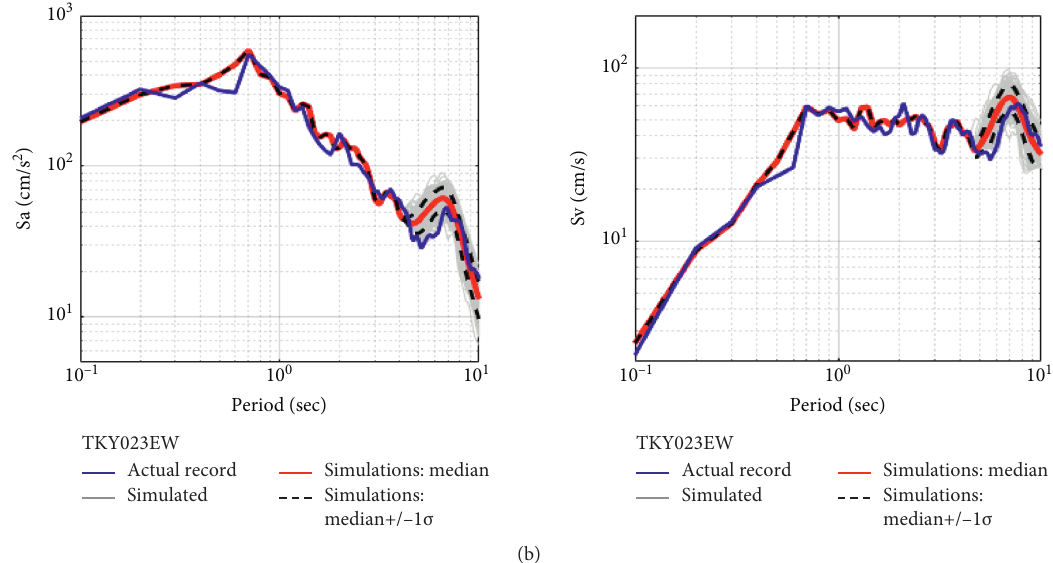
Figure 22: Response spectra (solid blue line) for the records CHB002EW and TKY023EW. Of 100 simulated long-period ground motions (thin gray lines), their median (thick red line) and median plus and minus one standard deviation ± σ (dashed lines) are involved; acceleration spectra on the left side; velocity spectra on the right side. (a) CHB002EW and (b) TKY023EW.